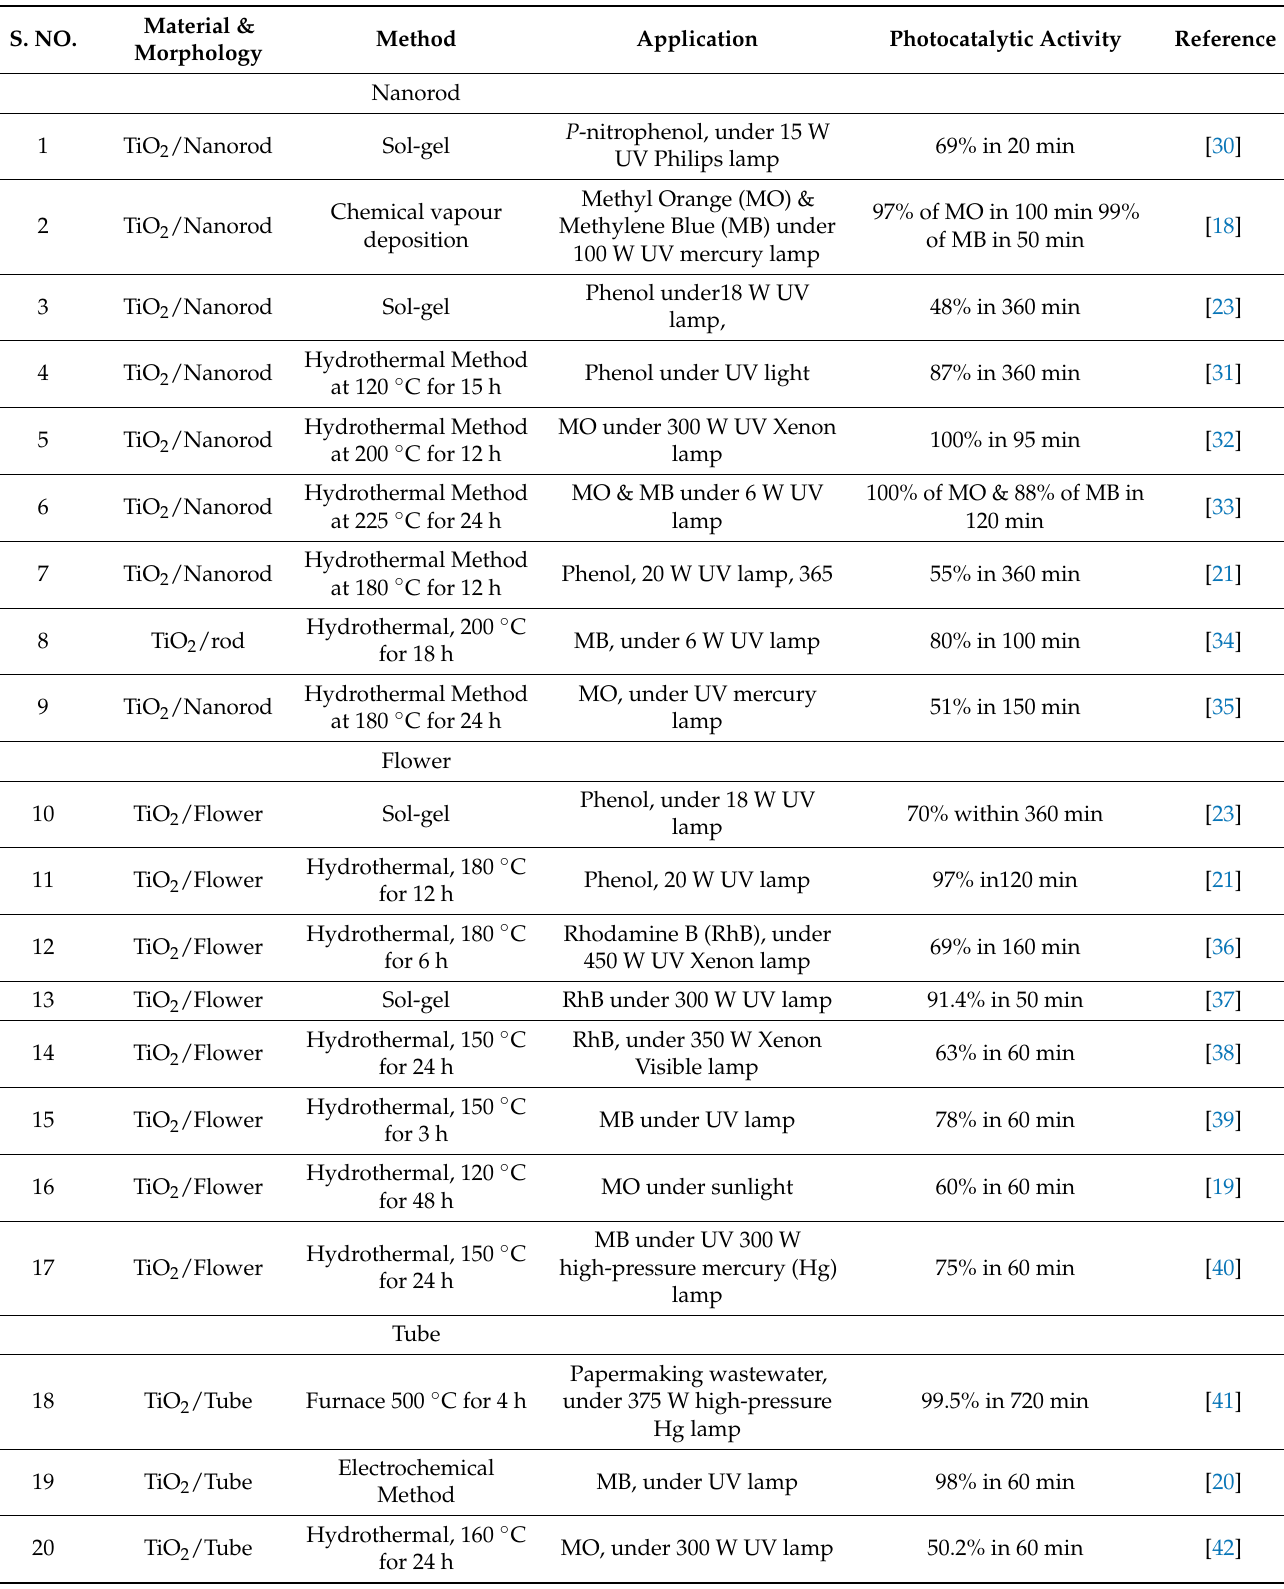
Table 1. Photocatalytic activity study of different nano morphologies of TiO 2